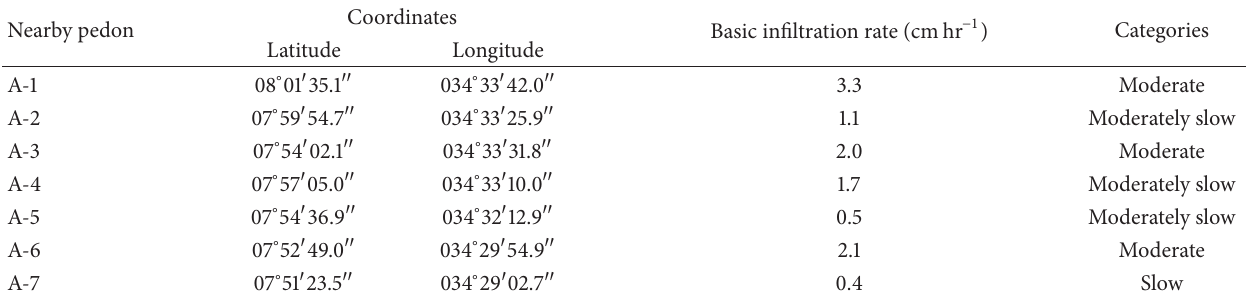
Table 5: Infiltration characteristics of soils of Abobo area.